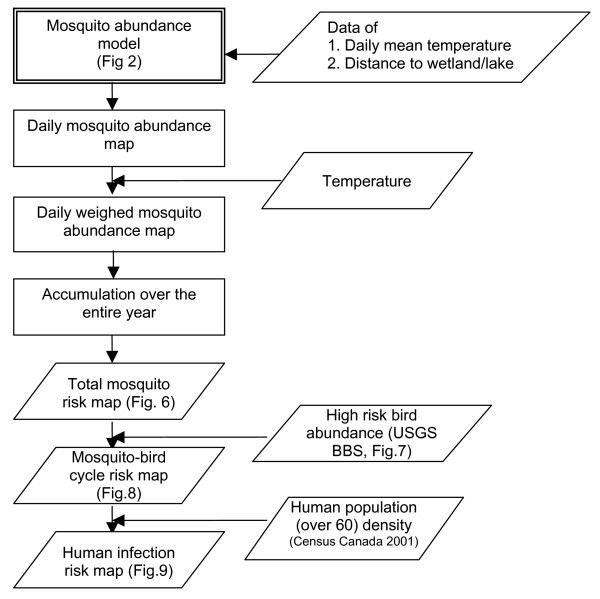
Flowchart illustrating the WNv risk assessment methodology used in the study.